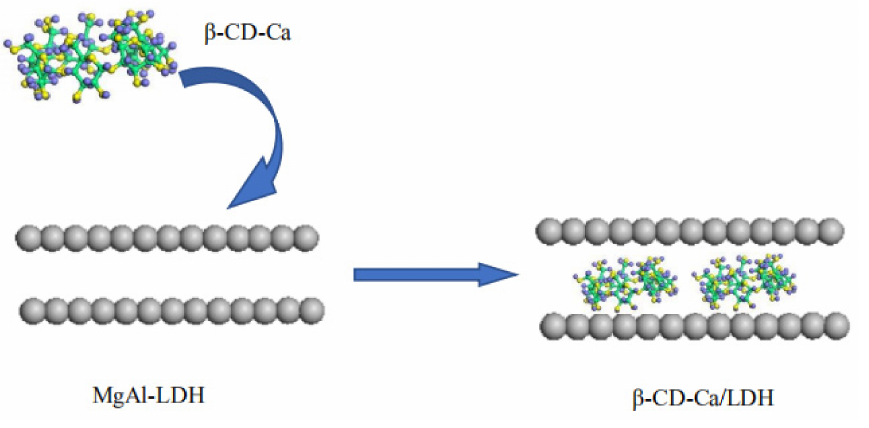
Figure 11. Synthesis diagram of β -CD-Ca intercalated Mg-Al